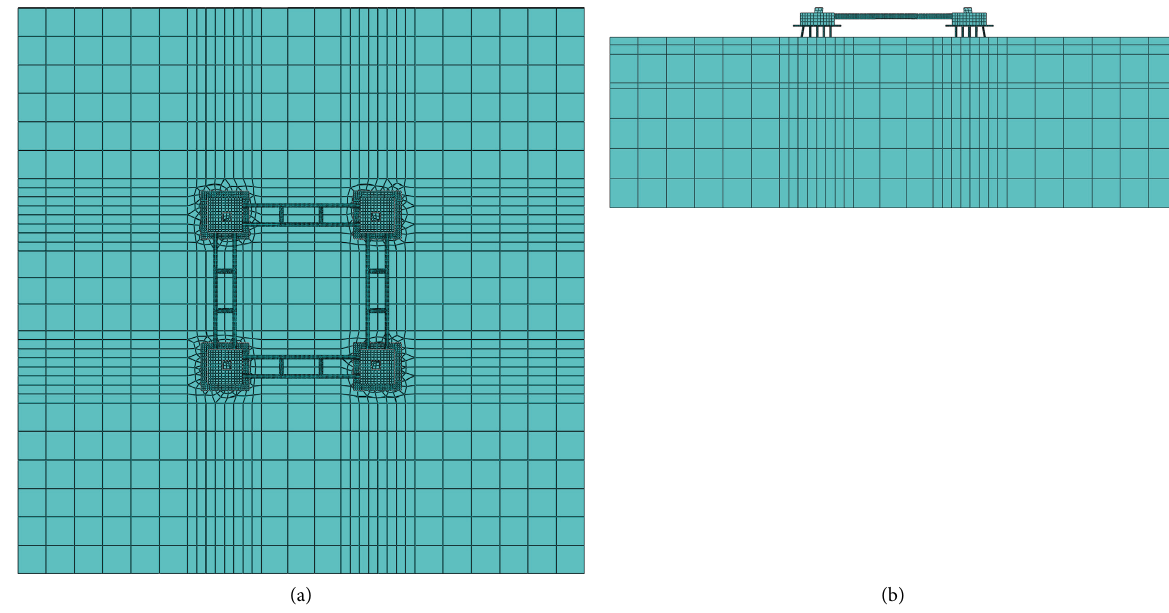
Figure 3: Diagram of grid division: (a) vertical view; (b) lateral